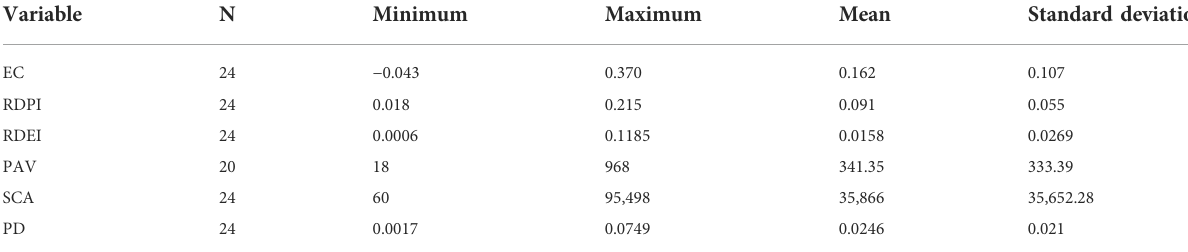
TABLE 2 Analysis of descriptive statistics.